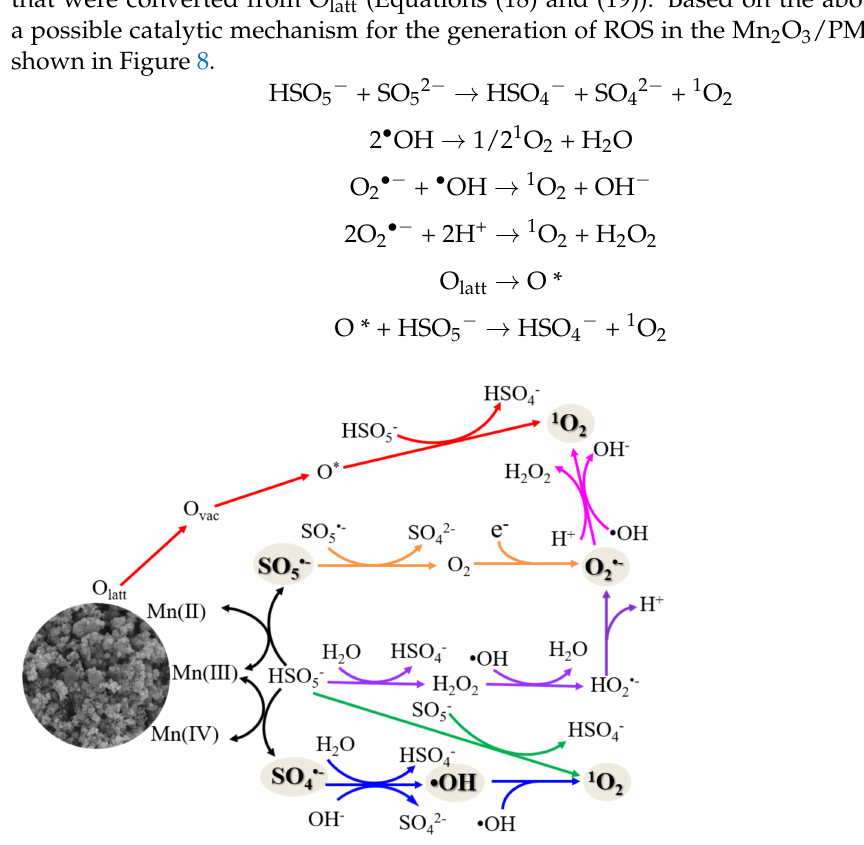
Figure 8. Hypothetic mechanisms of reactive oxygen species generation in the Mn 2 O 3 /PMS